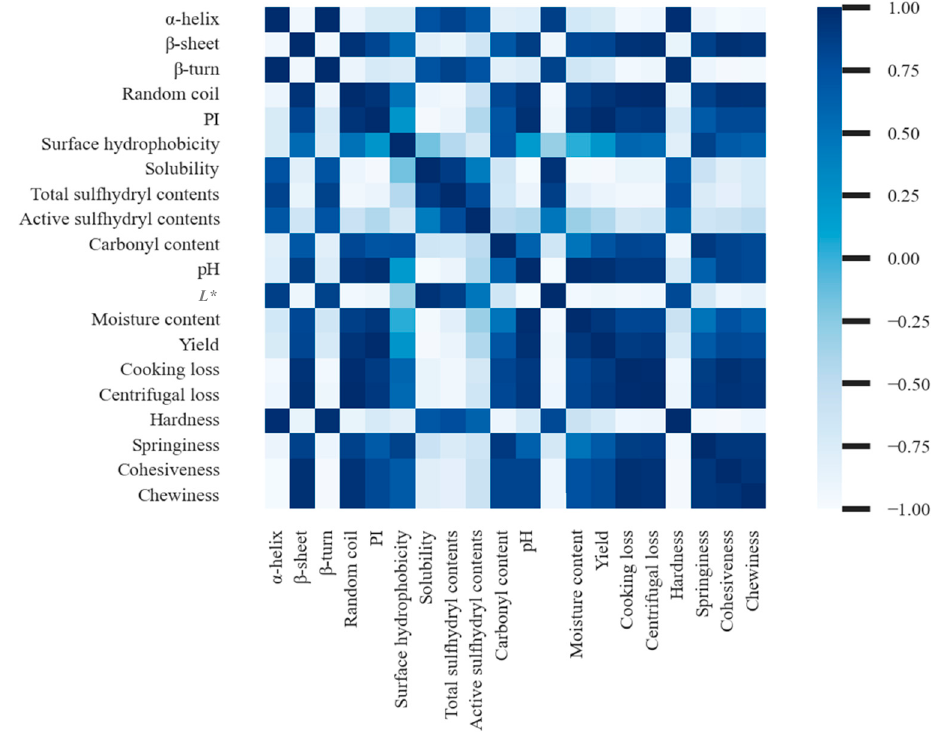
Figure 5. Pearson’s correlation analysis and levels of significance for correlations between protein properties and quality attributes with different KCl replacements of salted tilapia fillets as affected by different replacement of NaCl with KCl.